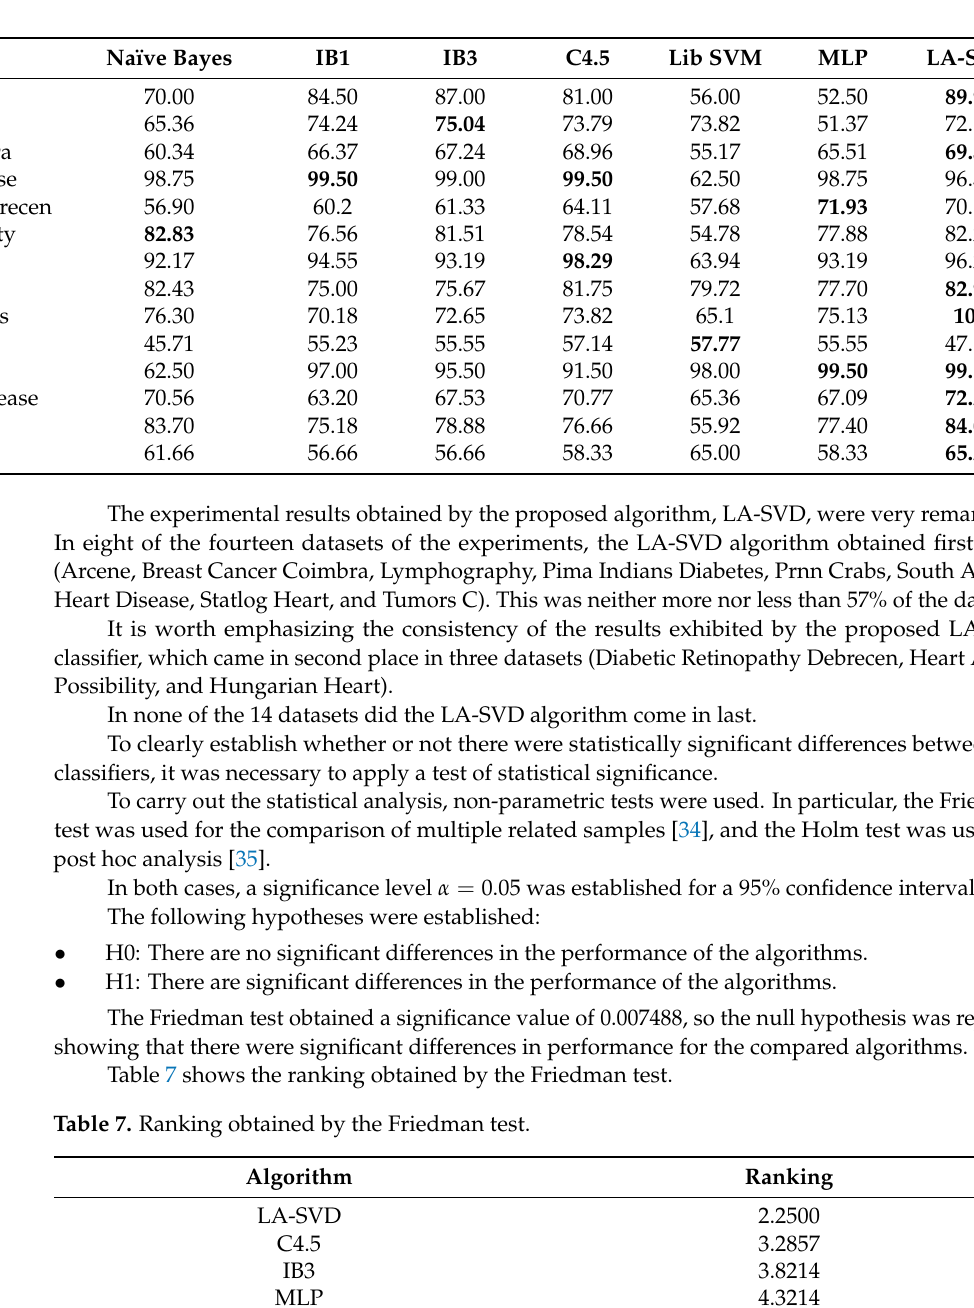
Table 6. Accuracy values (in %) exhibited by the LA-SVD algorithm and by six simple classifiers (best values in bold and framed).